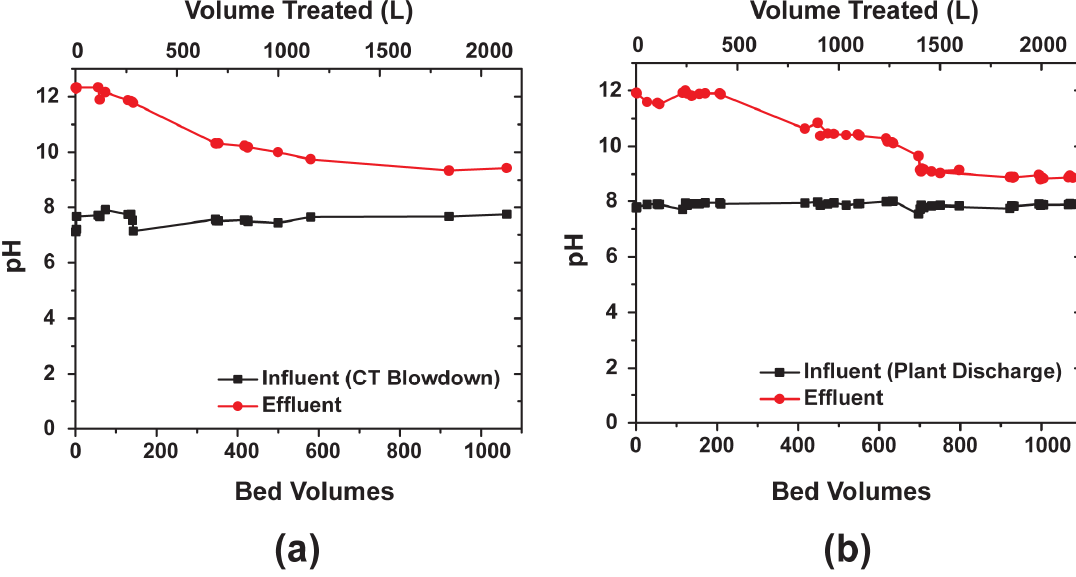
Figure 6. Influent and effluent pH of ( a ) cooling tower blowdown and ( b ) plant discharge wastewater in the testbed column test.